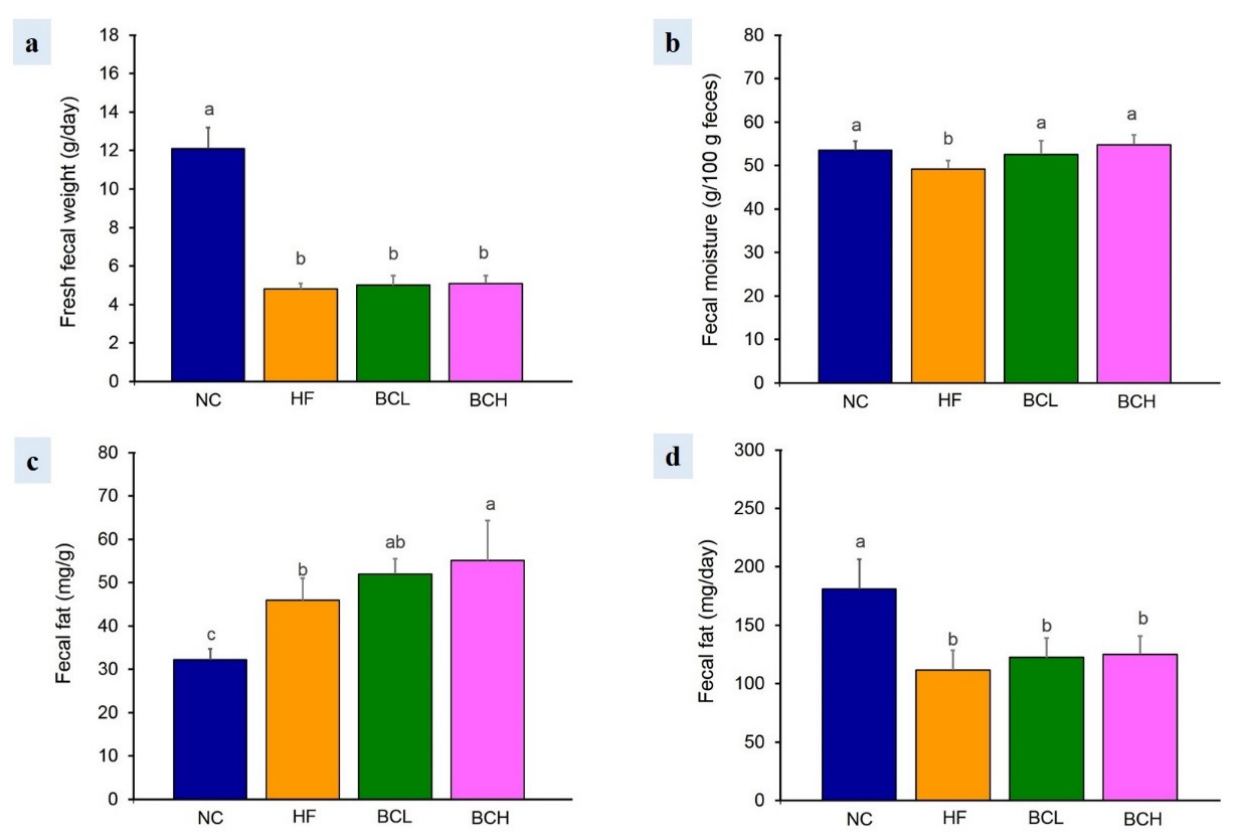
Figure 1. Variations in ( a ) fresh fecal weight, ( b ) fecal moisture, ( c ) fecal fat (mg/g), and ( d ) fecal fat (mg/day) within rats fed chow diet (NC group), high-fat diet (HF group), high-fat diet + low dose of B. coagulan BACO-17 (7 log CFU/day) (BCL group), and high-fat diet + high dose of B. coagulan BACO-17 (9 log CFU/day) (BCH group) ( n = 5 per group). a–c: Bars with different letters are significantly different, p < 0.05.